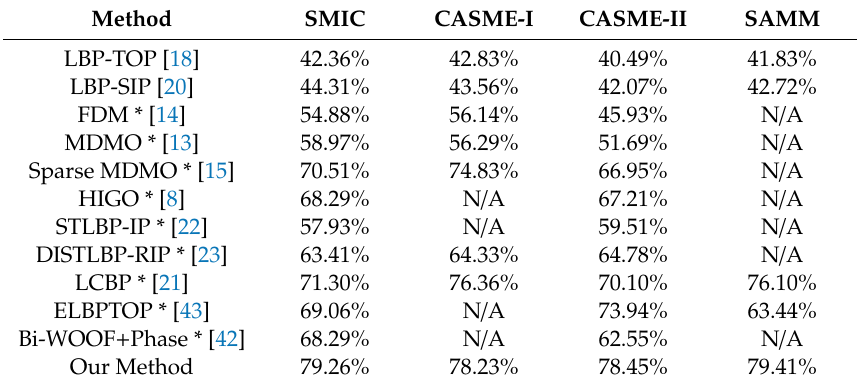
Table 4. Comparison of recognition results among the proposed micro-expression (ME) recognition method and recent state-of-the-art methods.